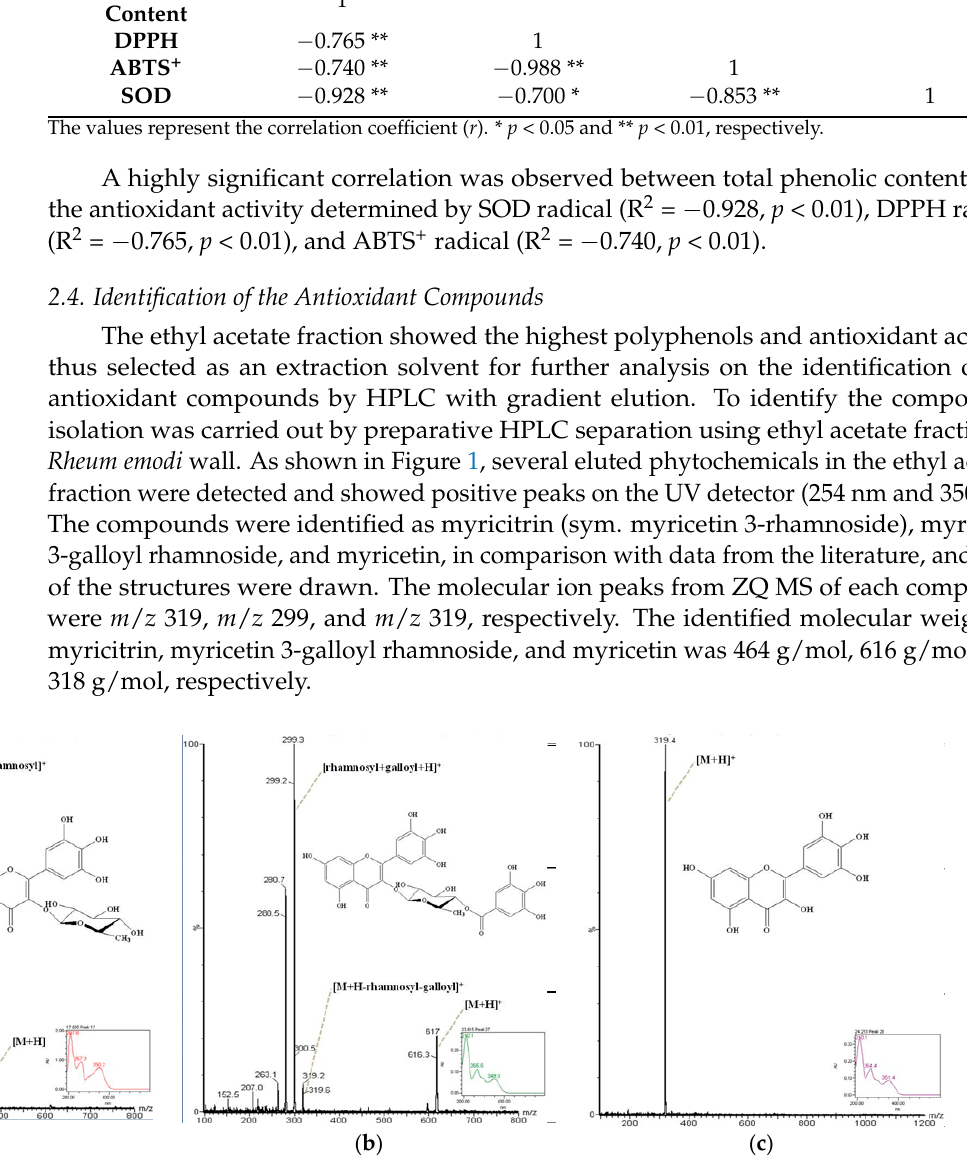
Figure 1. HPLC profiles, UV spectrum, and chemical structures of identified antioxidant compounds. ( a ) Myricitrin; ( b ) myricetin 3-galloyl rhamnoside; ( c ) myricetin.